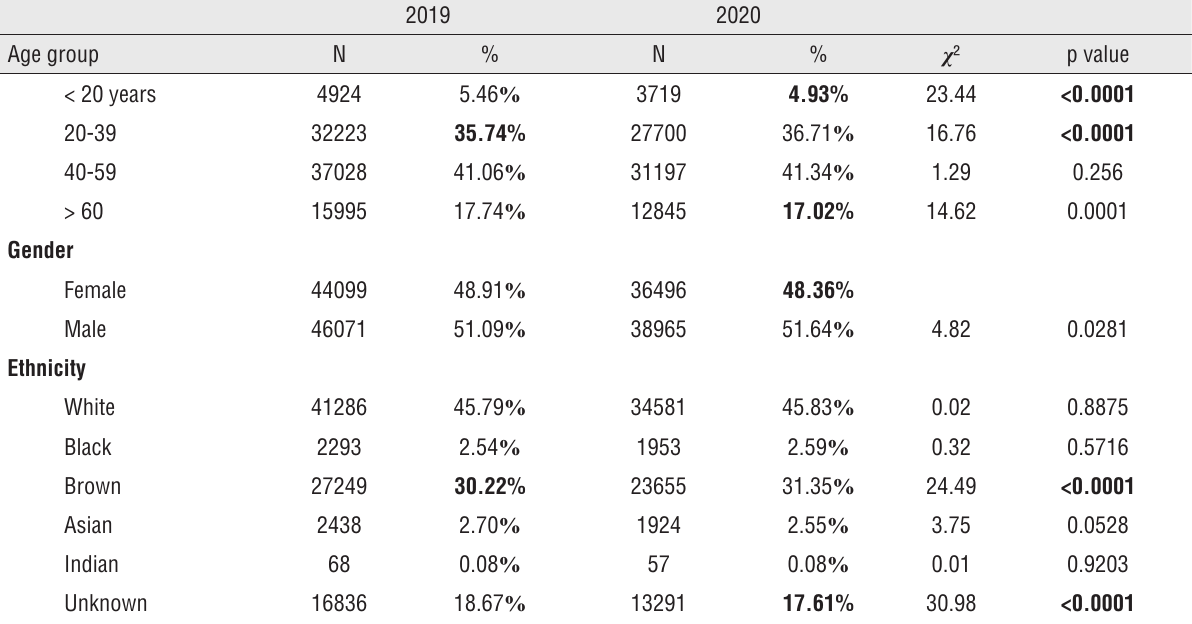
Table 1 - Hospital admissions for urolithiasis according to age groups, gender and ethnicity (Brazil, 2019 vs.